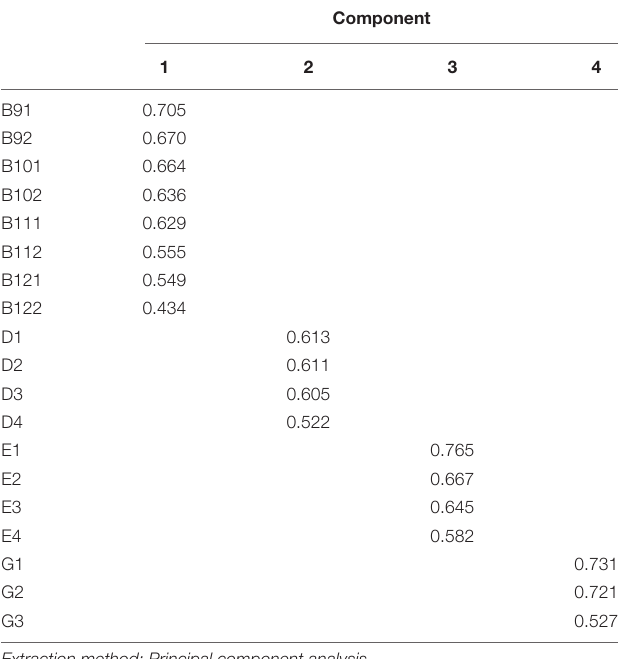
TABLE 4 | Rotated component matrix a .